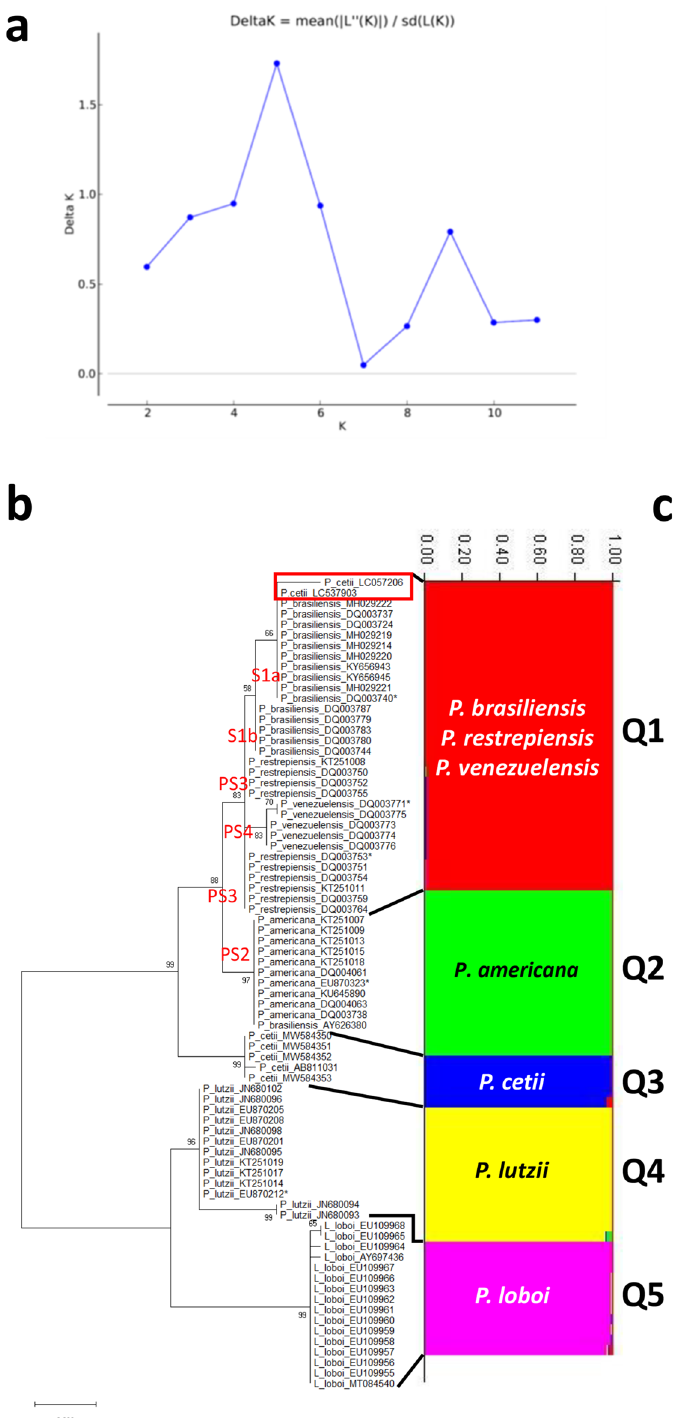
Figure 4. Estimation of population using LnP(D) derived ΔK for K, from 1 to 10 (K = 5), using Gp43 DNA sequences (Panel a ). Evolutionary analyses inferred by Maximum Likelihood of the Gp43 DNA sequences displays five monophyletic clusters ( b ) corresponding also to five STRU CTU RE populations (Q1 to Q5) ( c ). STRU CTU RE clustered P. brasiliensis (1Sa, 1Sb), P. restrepiensis (PS3), P. venezuelensis (PS4), in population Q1 (red), whereas the remaining species ( P. americana [PS2, green], P. cetii [blue], P. lutzii [yellow] and P. loboi [pink]) grouped as independent populations (Q2 to Q5). The numbers on the y-axis show the subgroup membership and the x-axis the different accessions (Q) (Panel c ). The distribution of accessions into different populations is indicate by color and